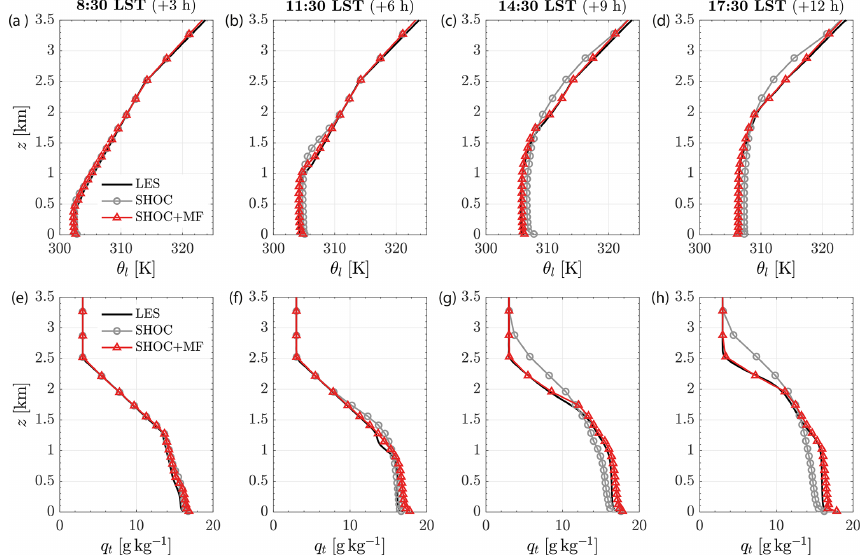
Figure 3. Vertical profiles of (a–d) liquid water potential temperature and (e–h) total water mixing ratio for LES (solid black line), SHOC (solid grey line), and SHOC + MF (solid red line) for the ARM shallow cumulus case. The label “HH:MMLST ( + X h)” shows the local standard times (LST) and the hour mark relative to the start of the simulation. The profiles correspond to hourly averages around the hour marked on each column (HH:MMLST ±